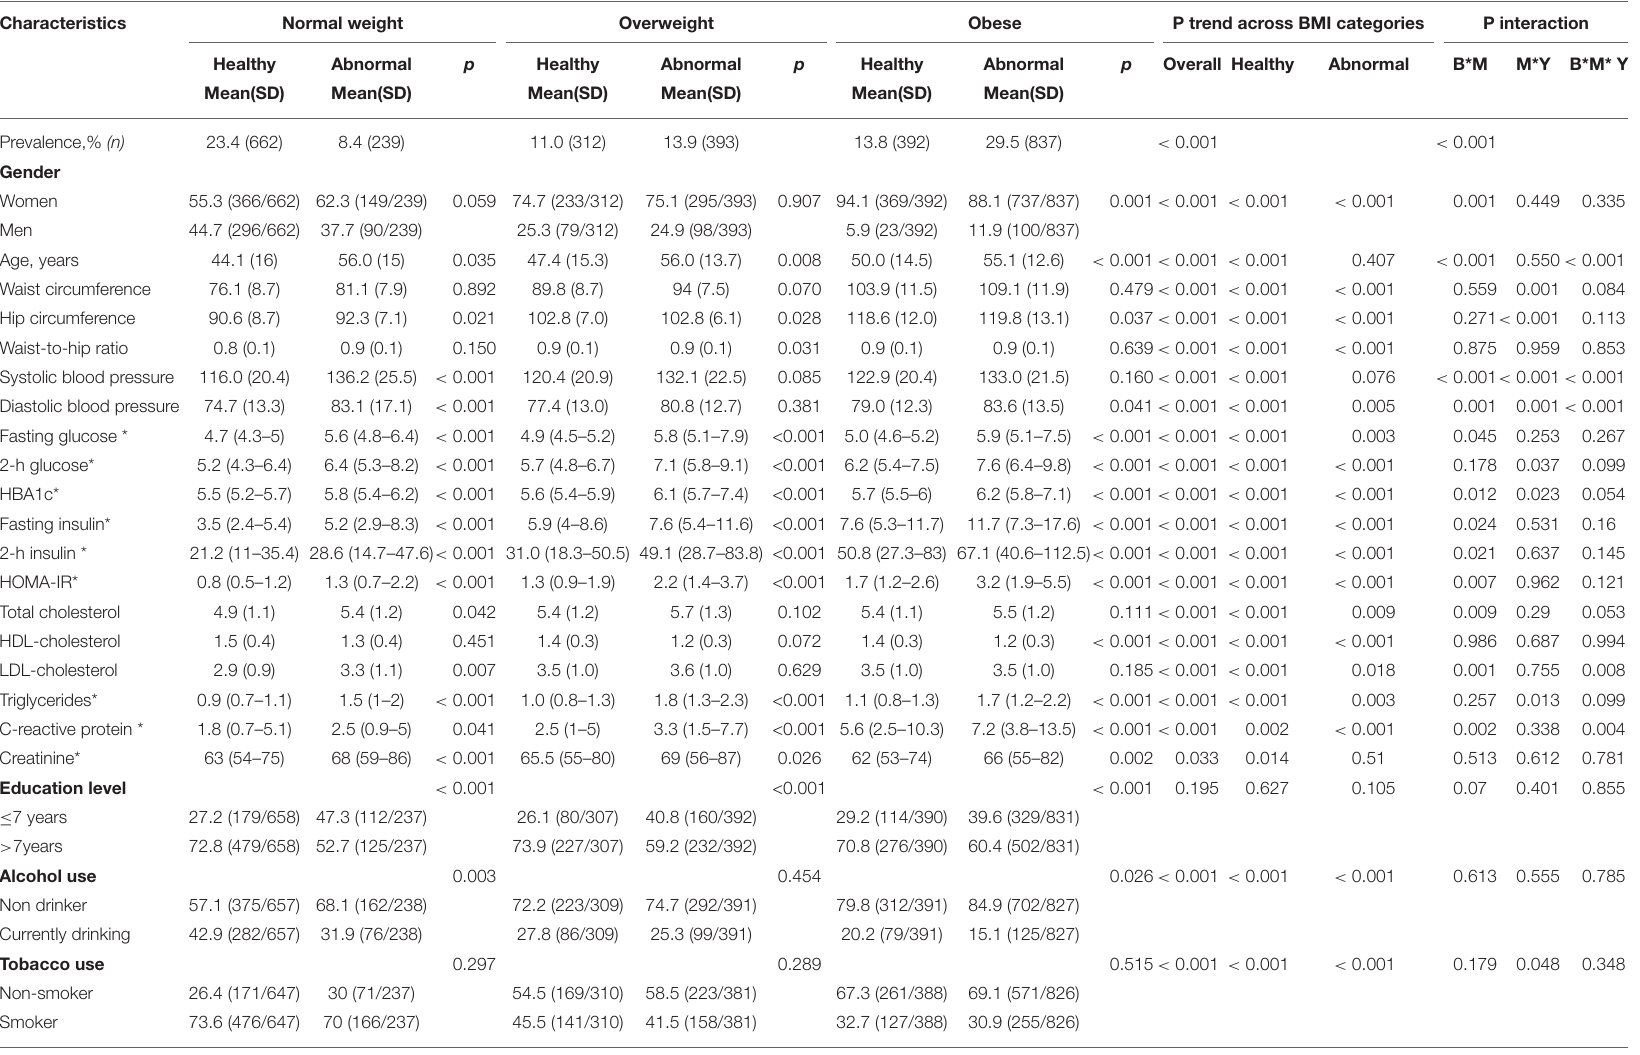
TABLE 2 | Pairwise comparison of metabolically healthy and abnormal participants by body mass index.